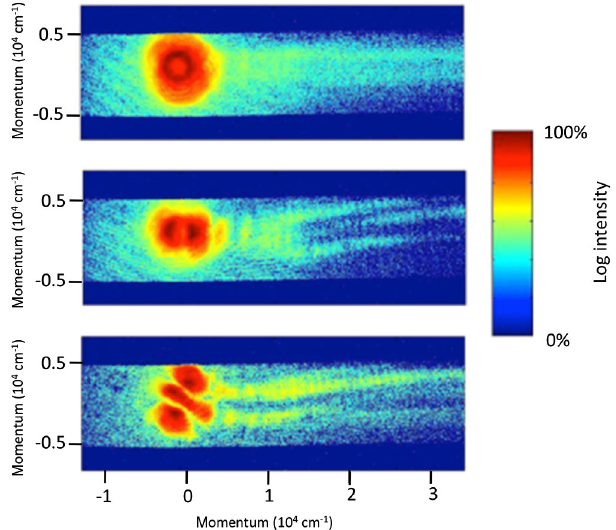
FIG. 4. Two-dimensional far-field k -space images of the emis- sion at different times, with 5-ms time averaging, from the trapped polariton state seen in Figs. 1(c) and 2(d). The horizontal direction is in the direction of the cavity-energy gradient, with downward to lower energy corresponding to motion to the